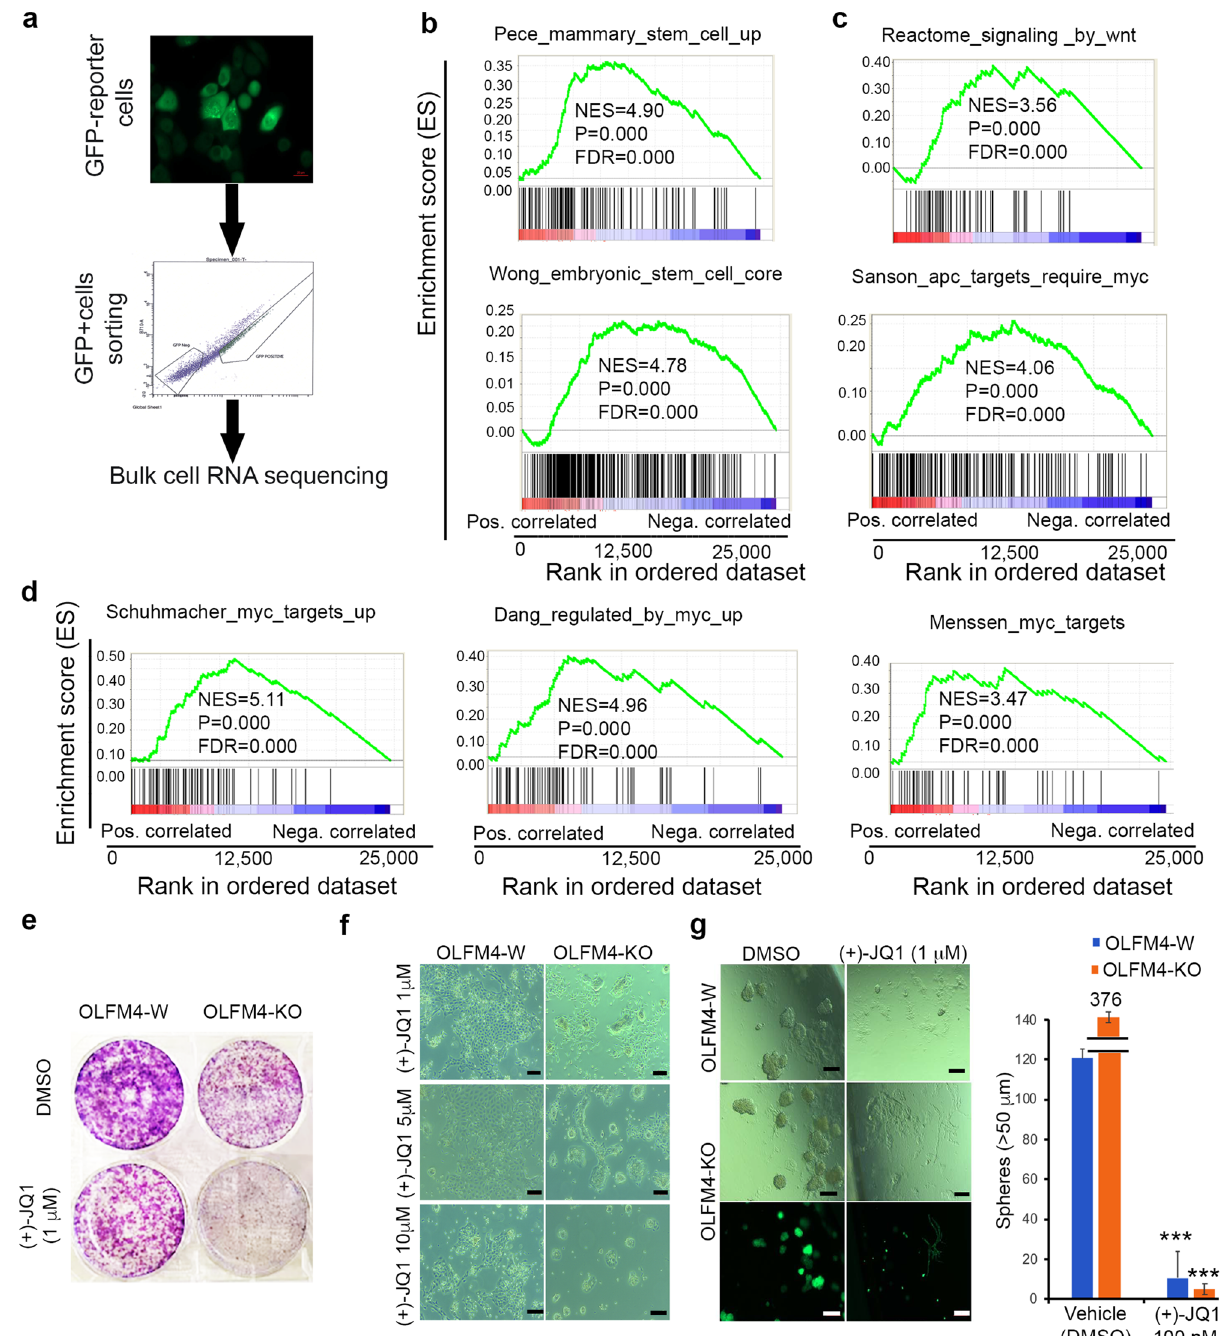
Figure 5. GSEA analysis for OLFM4 -knockout GFP reporter RWPE1 cells from bulk-cell RNA sequencing data. ( a ) Strategy of bulk-cell RNA sequencing for FACS cell sorting by GFP-marker expression of OLFM4 -GFP reporter RWPE1 cells. ( b ) GSEA showing enrichment of stem-cell-like gene signatures in OLFM4 -knockout GFP reporter RWPE1 cells. ( c ) GSEA showing enrichment of WNT -signaling and APC / MYC -signaling target gene signatures in OLFM4 -knockout GFP reporter RWPE1 cells. ( d ) GSEA showing enrichment of MYC target gene signatures in OLFM4 -knockout GFP reporter RWPE1 cells from three different data resources. ( e ) Representative images of colonies of OLFM4 -wild and OLFM4 -knockout GFP reporter RWPE1 cells cultured in the presence of 1 µM (+)-JQ1 (or DMSO, vehicle control) for 7 days in 6-well plates, then stained with the Diff-Quik Stain Set. ( f ) Representative images of colonies of OLFM4 -wild and OLFM4 -knockout GFP reporter RWPE1 cells cultured in the presence of 1 µM, 5 µM, or 10 µM (+)-JQ1 (or DMSO, vehicle control) for 7 days. Scale bar: 100 µm. ( g ) Representative GFP- and light-field images of spheres of OLFM4 -wild and OLFM4 -knockout GFP reporter RWPE1 cells cultured in the presence of 1 µM (+)-JQ1 (or DMSO, vehicle control) for 10 days in 3D culture. Scale bar: 100 µm. Bar graph presents mean number of spheres (± SD, n = 6) from these experiments using 100 nM of (+)-JQ1 (or DMSO, vehicle control). W, wild; KO, knockout. *** p < 0.001 (Student’s